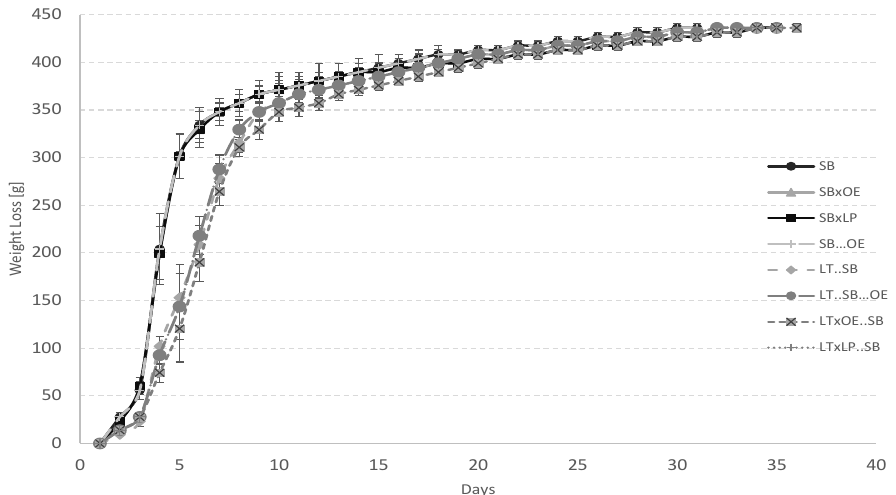
Figure 1. Fermentation kinetics of gravimetrically measured variants by total weight loss in course of fermentation. S. bayanus alone (SB); coinoculation of S. bayanus and O. oeni (SB × OE); coinoculation of S. bayanus and L. plantarum (SB × LP); sequential fermentation with S. bayanus and O. oeni after alcoholic fermentation (SB . . . OE); sequential fermentation with S. bayanus and L. thermotolerans during alcoholic fermentation (LT..SB); sequential fermentation with S. bayanus and L. thermotolerans during alcoholic fermentation, followed by O. oeni after alcoholic fermentation (LT..SB . . . OE); coinoculation of L. thermotolerans and O. oeni, followed by S. bayanus (LT × OE..SB); and coinoculation of L. thermotolerans and L. plantarum, followed by S. bayanus (LT LP..SB). Table 2. Final chemical analysis of fermentations from Tempranillo red grapes : S. bayanus alone (SB); coinoculation of S. bayanus and O. oeni (SB OE); coinoculation of S. bayanus and L. plantarum (SB LP); sequential fermentation with S. bayanus and O. oeni after alcoholic fermentation (SB…OE); sequential fermentation with S. bayanus and L. thermotolerans during alcoholic fermentation (LT..SB); sequential fermentation with S. bayanus and L. thermotolerans during alcoholic fermenta- tion, followed by O. oeni after alcoholic fermentation (LT..SB…OE); coinoculation of L. thermotolerans and O. oeni, followed by S. bayanus (LT OE..SB); and coinoculation of L. thermotolerans and L. plantarum, followed by S. bayanus (LT LP..SB). The initial studied characteristics of the must before alcoholic fermentation were: sugar concentration 260 g/L, pH = 3.88, primary amino nitrogen = 256 mg/L, ammonia nitrogen = 21 mg/L, malic acid = 0.86 g/L, and lactic and acetic acid were below 0.1 g/L.